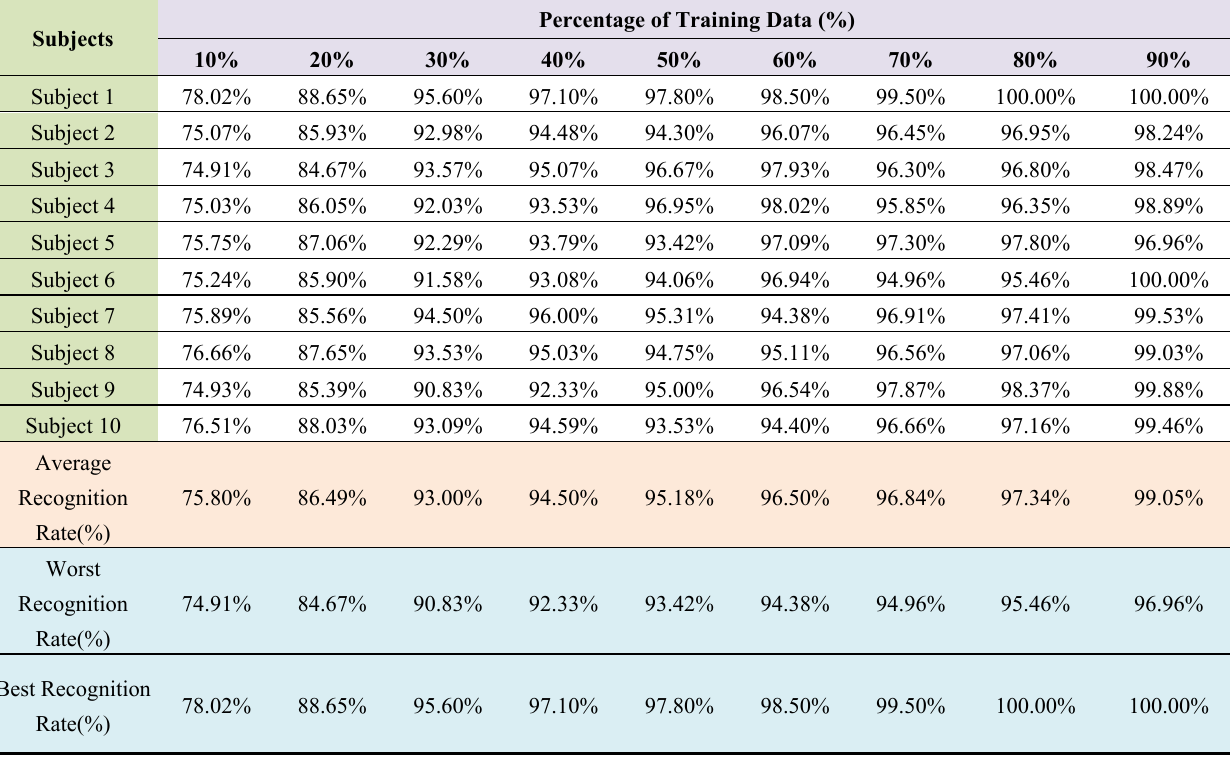
Table 3. The recognition results of walking, running, walking upstairs and walking downstairs from ten